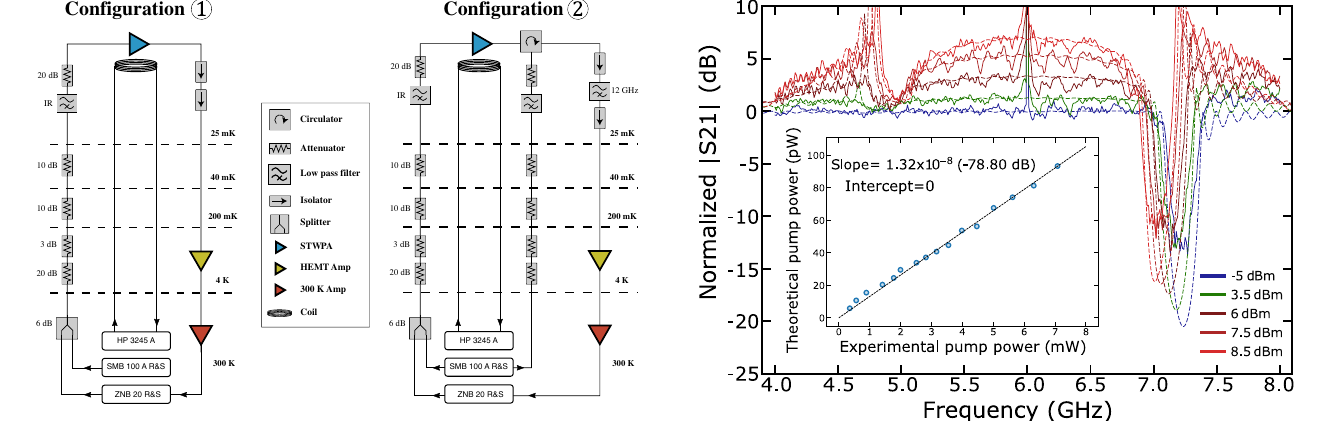
FIG. 13. Calibration via cross-Kerr shift. Comparison between experiment (full lines) and theory (dashed lines) for a pump tone sent at 6 GHz at various power. This figure is similar to Fig. 2, but with more pump power, demonstrating the robustness of the model. Inset: experimental and theoretical pump power needed to get the same frequency shift of the gap. The linear fit gives a ¼ − 78 . 8 system attenuation A total